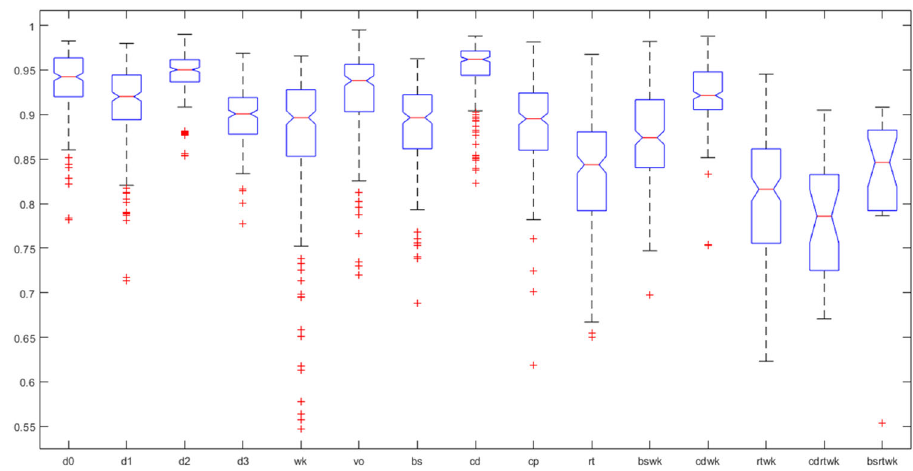
Fig. 4 Boxplot of R 2 -value-distribution of daily travel time according the respective modes of transport. The abbreviations of the modes of transport are: d 0, d 1, d 2, d 3, as de fi ned above, wk — walking, vo — velo or bike, bs — stage bus, cd — car driver, cp — car passenger, rt — rail, and the respective combinations.